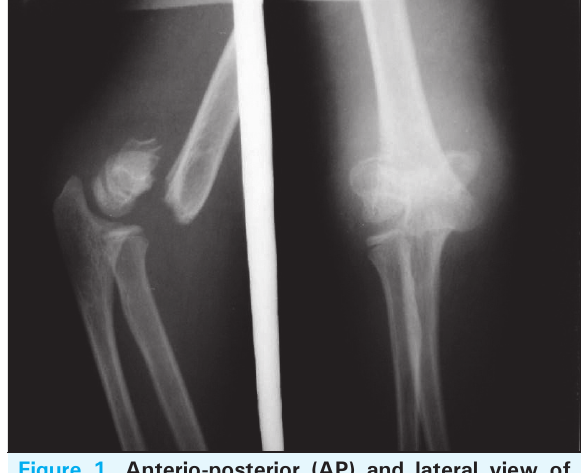
Figure 1. Anterio-posterior (AP) and lateral view of elbow showing gartland type III extension type of supracondylar fracture of humerus in an eight-year old